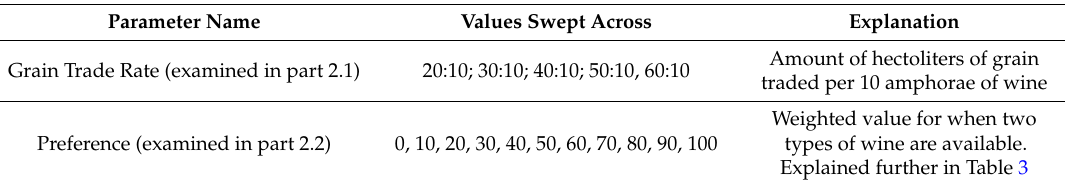
Table 3. Parameters swept across in two models. Grain Trade Rate was swept across in first model. Preference was swept across in second model. Values Swept Across Explanation Amount of hectoliters of grain Grain Trade Rate (examined in part 2.1) 20:10; 30:10; 40:10; 50:10, 60:10 traded per 10 amphorae of wine Preference (examined in part